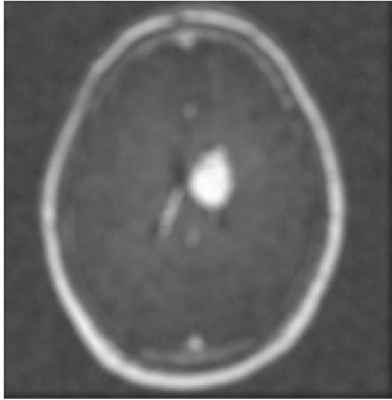
Figure 8: Ideal low-pass filter.